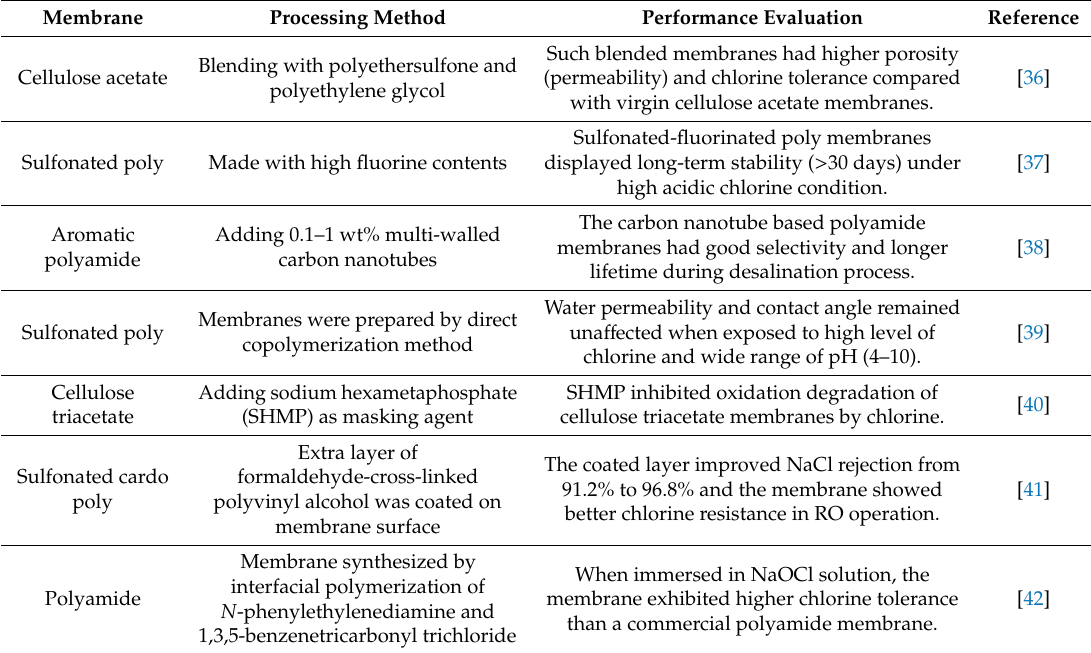
Table 2. E ff ects of various processing methods on chlorine